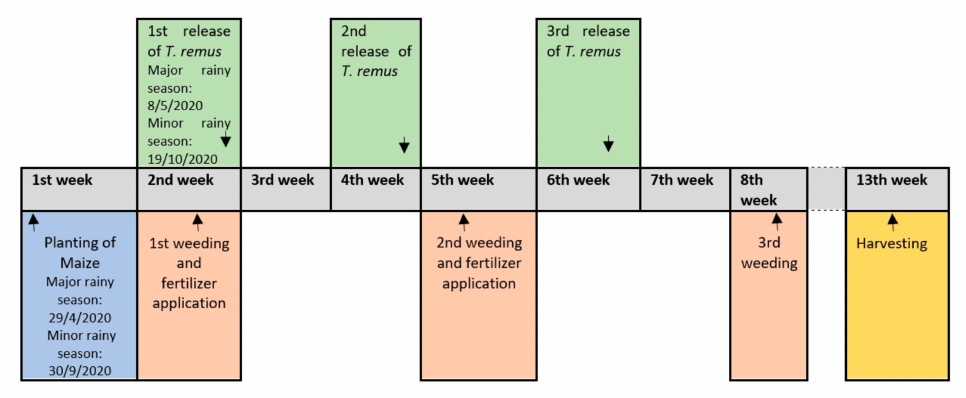
Figure 3. Overview on timelines for Telenomus remus releases and relevant crop management proce- dures in MTR and T0 maize